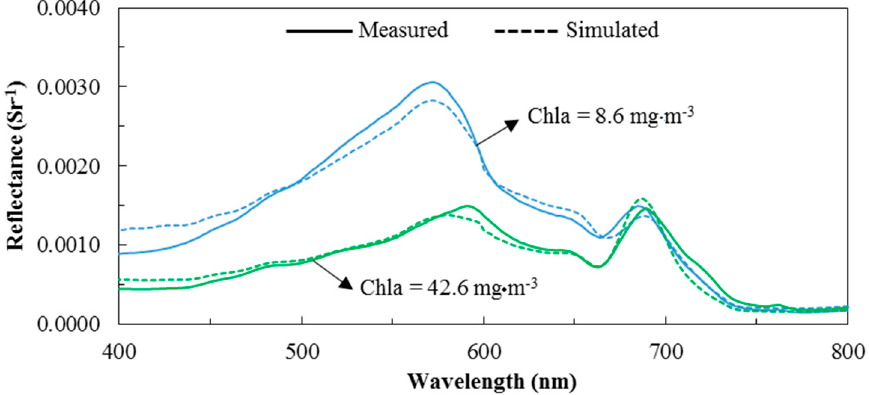
Figure 3. Measured versus simulated remote sensing reflectance spectra using measured inherent optical properties (IOPs) at two stations with chlorophyll- a (Chla) of 8.6 and 42.6 mg·m − 3 . The solid and dashed lines represent the measured and simulated reflectance, respectively.